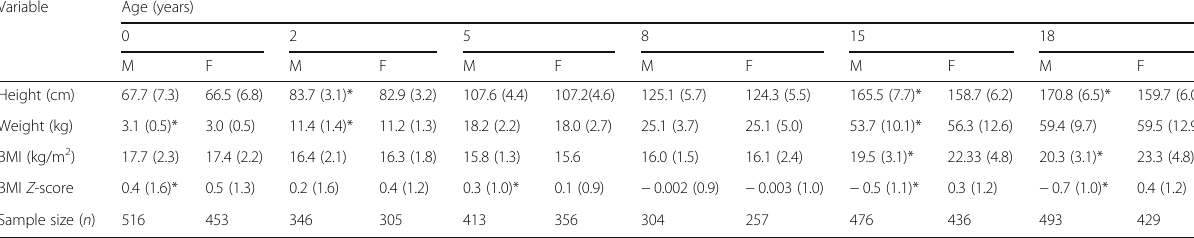
Table 1 Comparing study characteristics between boys and girls study participants